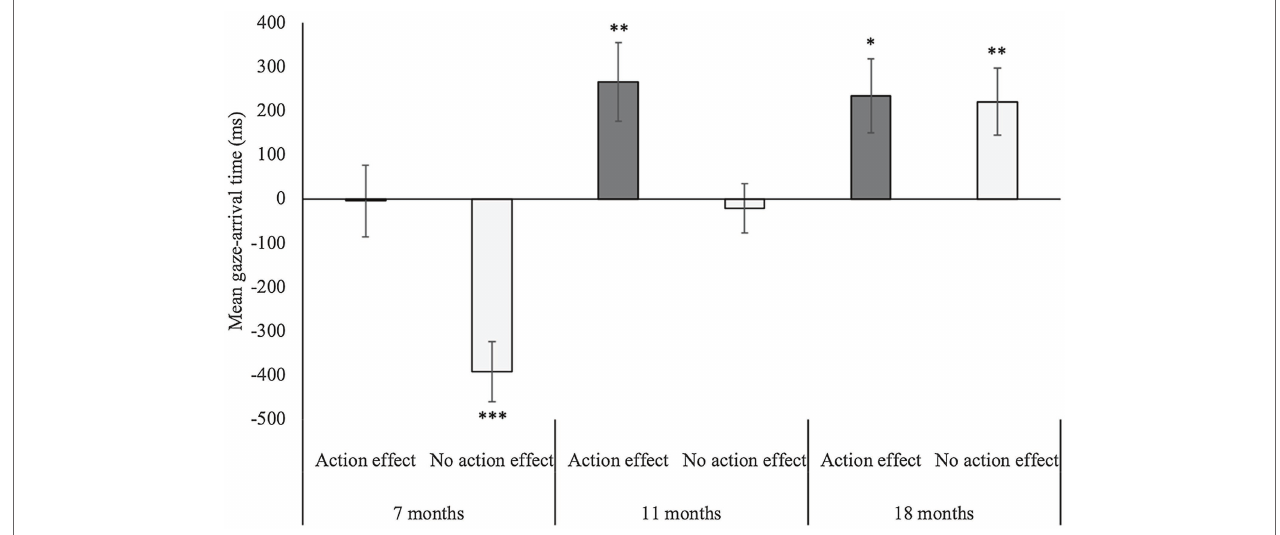
FIGURE 2 | Mean gaze-arrival times for the 7-, 11-, and 18-month-olds in the action-effect and the no-action-effect condition. Positive and negative values represent mean gaze-arrival times before and after the claw arrived at the goal AOI. Error bars represent standard-errors, and the asterisks mark mean gaze-arrival times significantly different from 0 ms. * = p < 0.05, ** = p < 0.01, and *** = p <